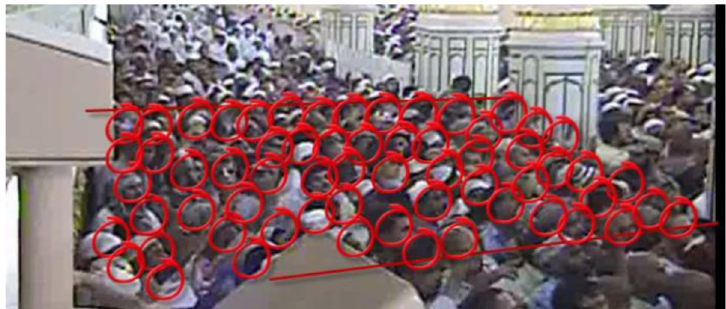
Figure 2. Manual counting of visitors